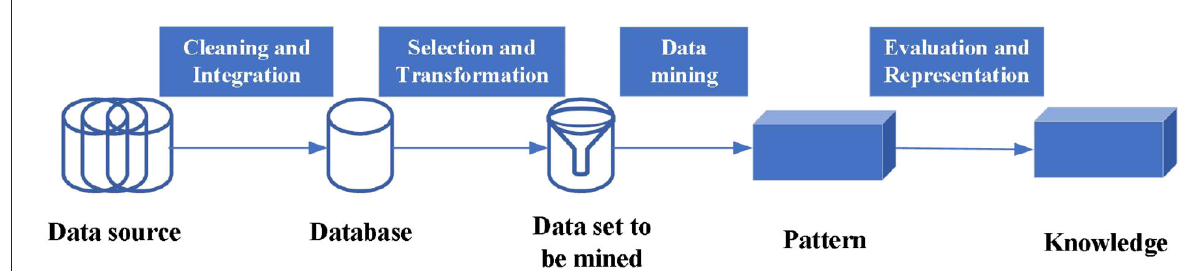
FIGURE1 The mining process of coastal zone monitoring data.